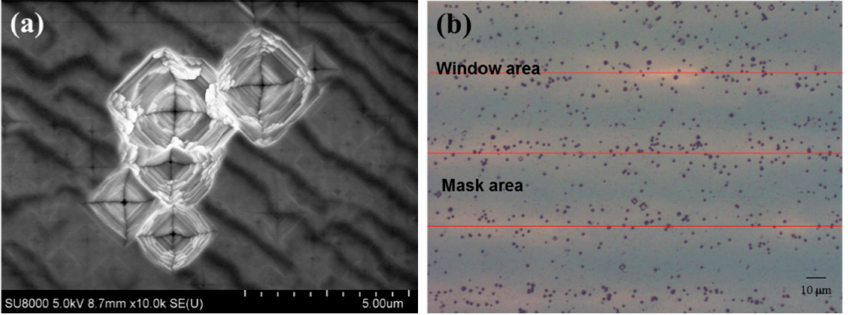
Figure 4. ( a ) FE-SEM image of etch-pits formed by plasma etching for 15 min. ( b ) Backlit optical image of the first ELO layer after plasma etching for 15